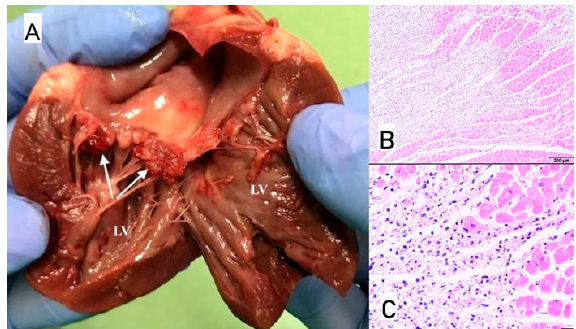
Figure 13. ( A ) Macroscopic view: white arrows point to the massive vegetations on mitral valve, LV—left ventricle. ( B ) Inflammatory infiltrate of myocardium; H-E, magnification 40×. ( C ) Higher magnification of inflamed area: infiltration with mononuclear cells is visible; H-E, magnification 100×.